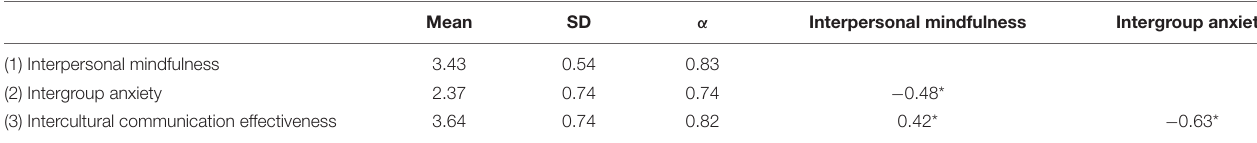
TABLE 1 | Descriptive statistics and correlations between